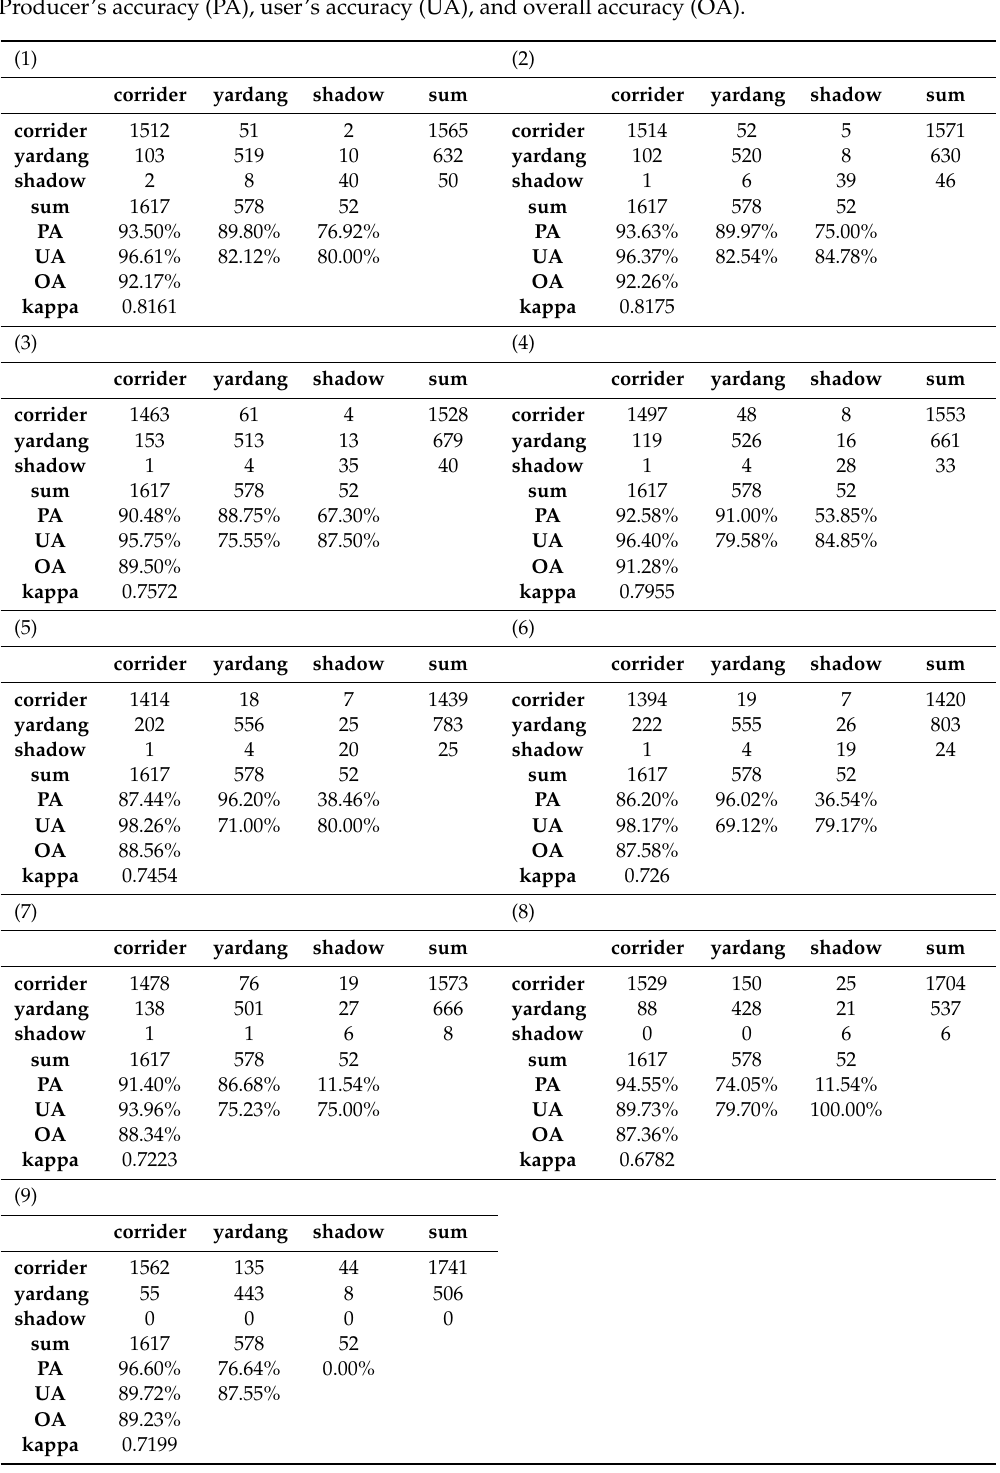
Table A1. Confusion matrix and accuracy assessment results using the two methods: (1)–(8) the OBIA method with di ff erent segmentation scales (SC) ((1) SC = 34,(2) SC = 52, (3) SC = 80, (4) SC = 114, (5) SC = 138, (6) SC = 145, (7) SC = 208, (8) SC = 257), and (9) Edge detection result using the CED